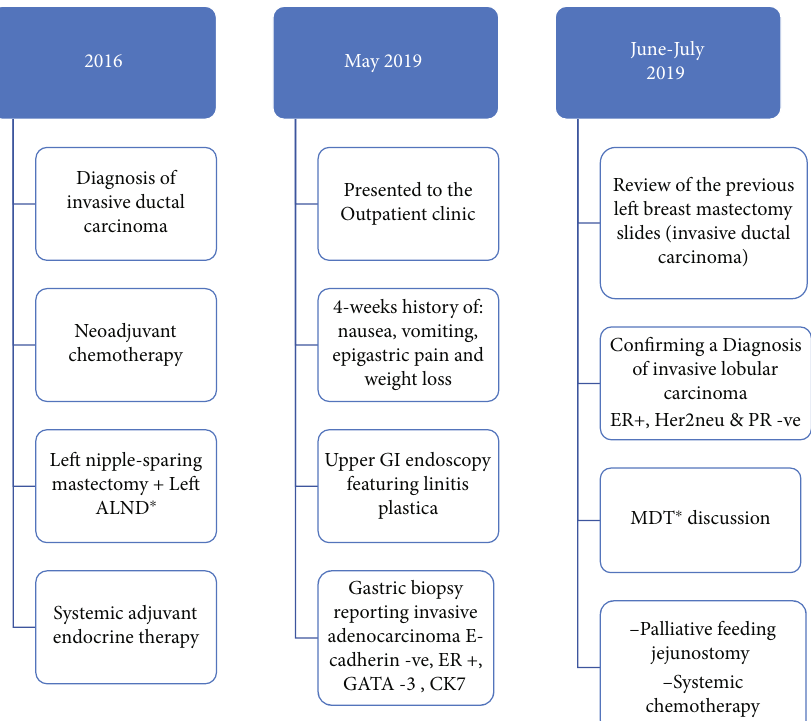
Figure 1: The patient ’ s medical history timeline and clinical case presentation. ALND: axillary lymph node dissection; ER+: estrogen receptor positive; MDT: multidisciplinary